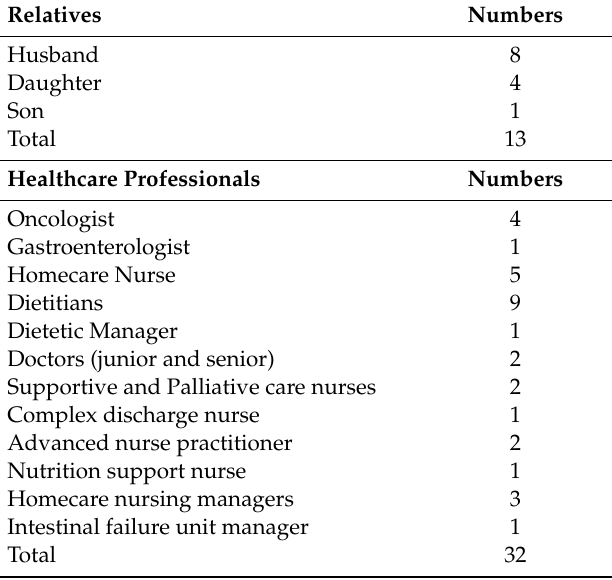
Table 1. Numbers of relatives and healthcare professionals